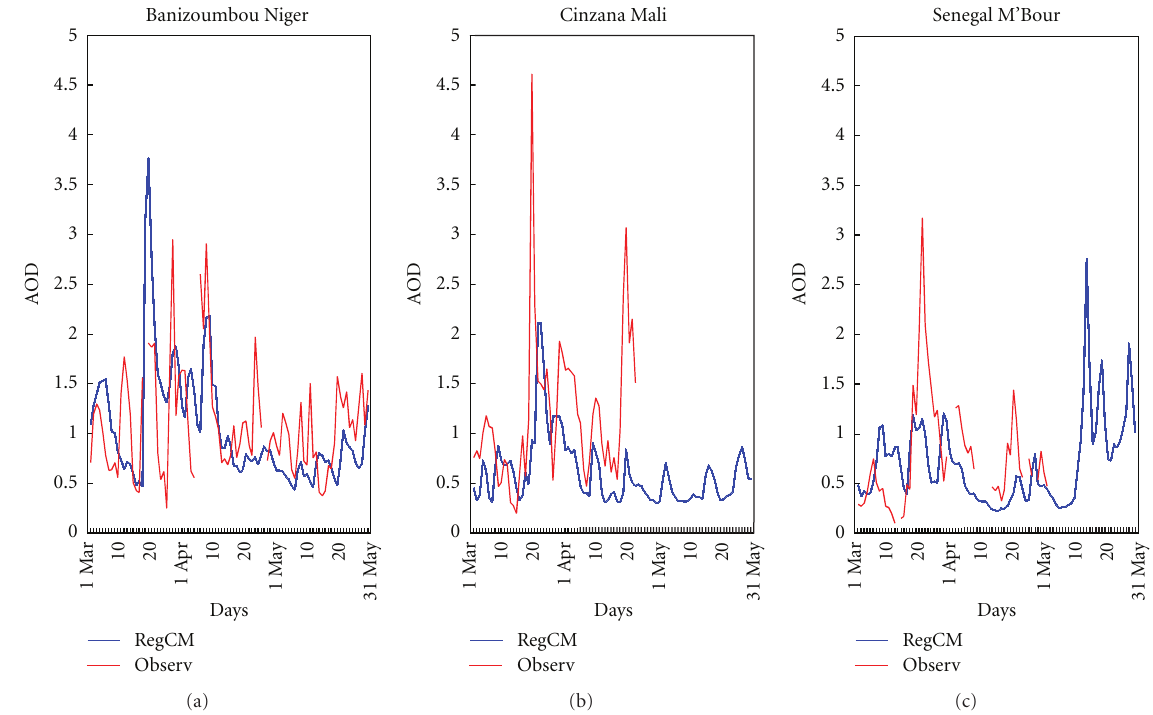
Figure 3: Comparison of AOD values between the RegCM 4.0 simulations and the observations made with the AERONET at 500 nm (from March to May